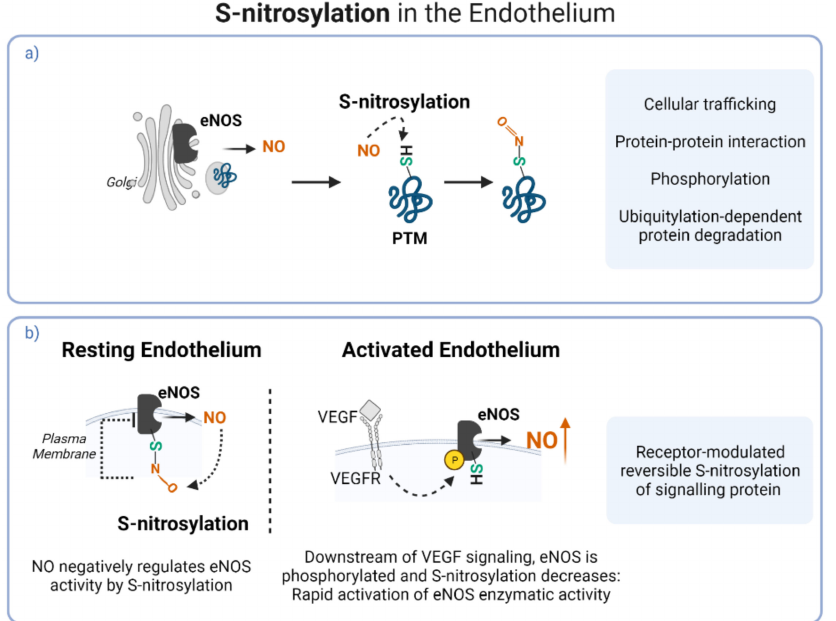
Figure 3. S-nitrosylation mechanisms in the endothelium. ( a ) eNOS-mediated S-nitrosylation of proteins as PTM. ( b ) S-nitrosylation negative, reversible, regulation of eNOS